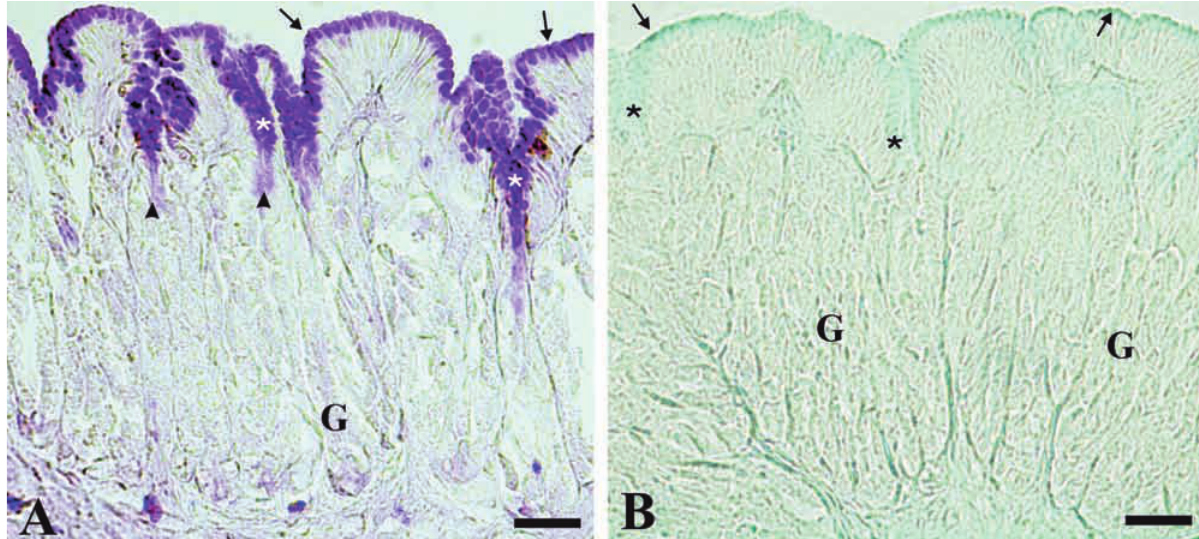
Fig . 2. – tunica mucosa of Halobatrachus didactylus stomach stained with PaS (a) and aB (B) methods. a, PaS reaction intensely marks the apical zone of the surface epithelial cells and the pit cells and very weakly the neck cells. B, aB 2.5 method shows very weak staining in the apical zone of surface epithelial cells and pit cells. G, gastric gland; arrow, surface epithelial cells; arrowhead, neck cells; asterisk, pit cells. Scale bars: 30 μm.